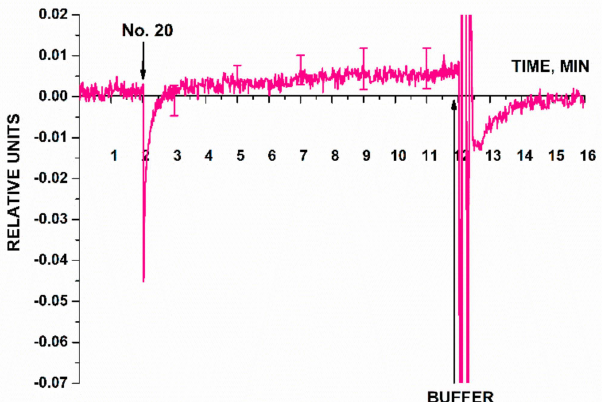
Figure 10. Typical sensogram obtained in the additional control experiment. The signal from the nanowire sensitized with immobilized oDNA probe not specific to any target miRNA (probe_5) was recorded in the case of adding miRNA solution isolated from the plasma sample of a patient with a verified diagnosis of ovarian cancer (No. 20). Experimental conditions: SOI-NW chip with n-type conductivity; the nanowire with immobilized oDNA probe (probe_5); 1 mM PPMB; pH 7.4; V g = 50 V, V ds = 0.4 V; the total solution volume in the cell was 107 µ L. Number of technical replicates, n = 3. Arrows indicate the time points of addition of the analyzed miRNA solution and the pure washing buffer into the